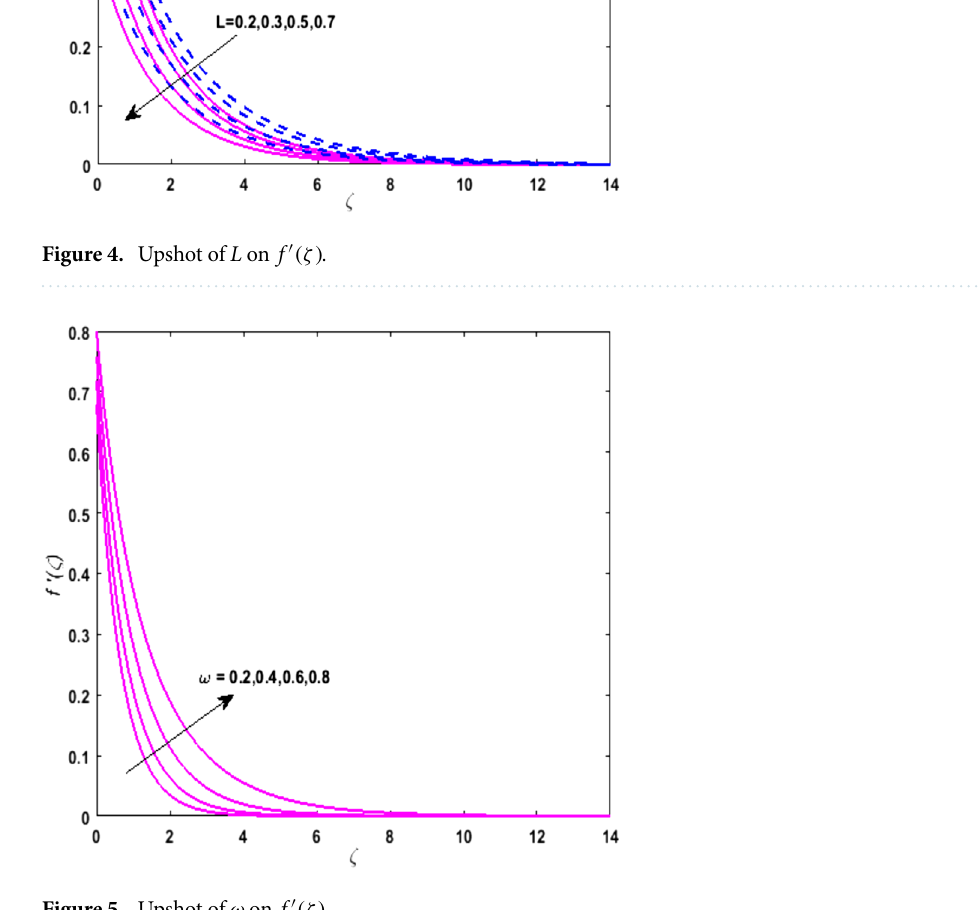
Figure 5. Upshot of ω on f ′ (ζ)